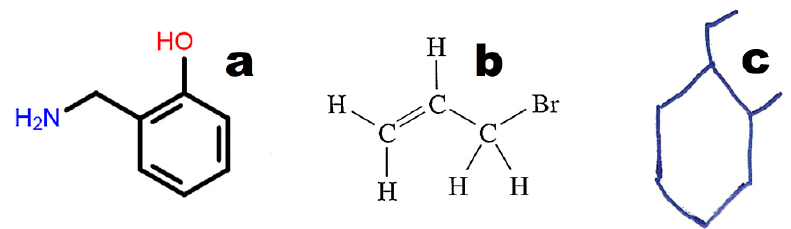
Figure 3. Examples of molecular structures recognized by OSRA: ( a ) structure drawn in a molecular editor using basic primitives; ( b ) classical structure from printed text; ( c ) hand-drawn structure. Int. J. Mol. Sci. 2016 , 17 , 2039 8 of 23